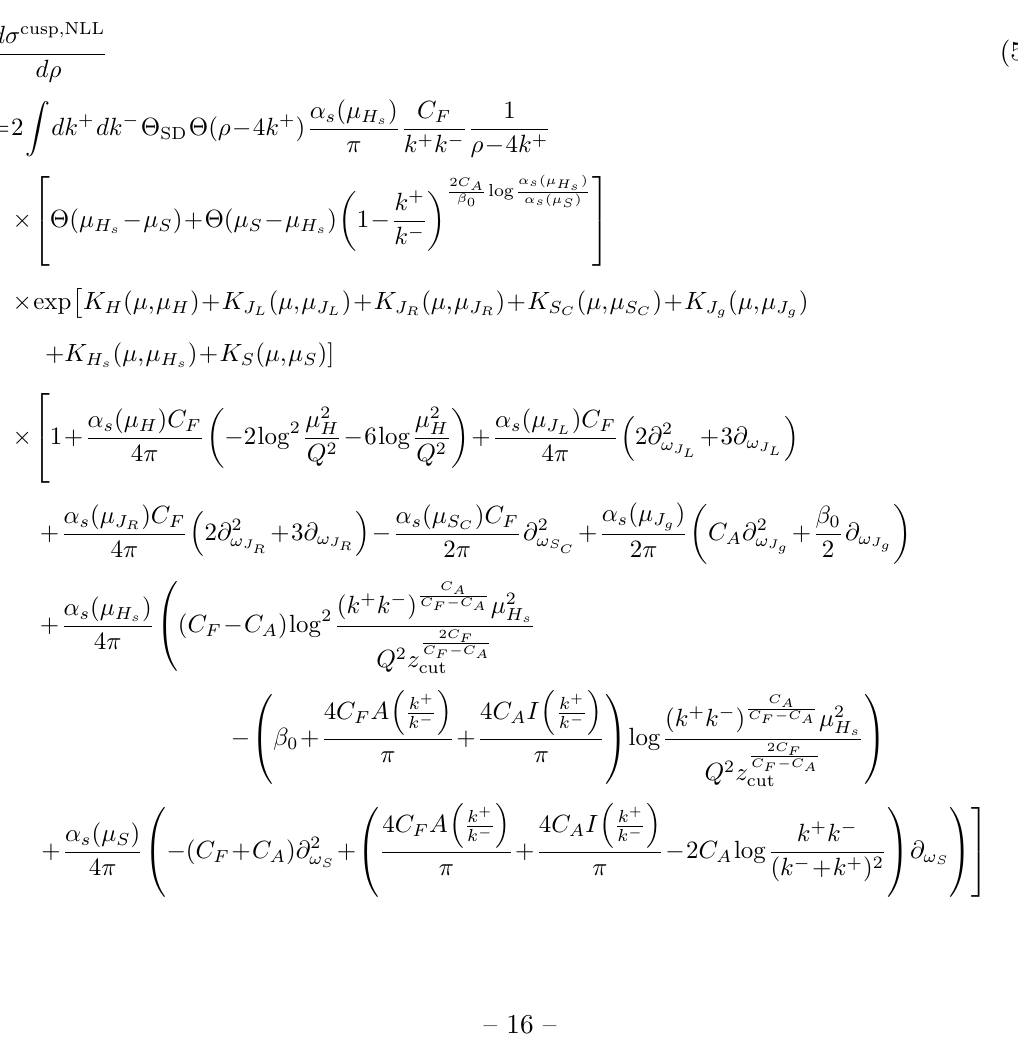
Figure 3 . Comparison between the value of the n f channel of the O ( α 2 differential cross section for the mMDT groomed heavy hemisphere mass at the cusp location of ρ = 2 z cut from eq. (4.20) and EVENT2, as a function of z cut